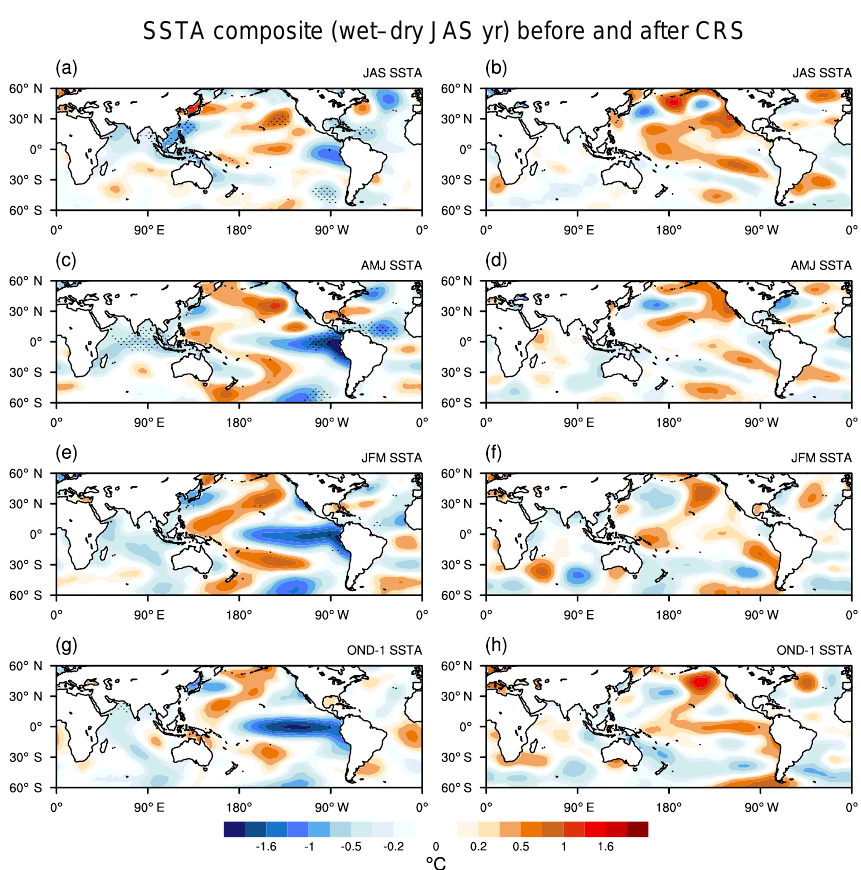
Figure 8. Evolution of SSTA composites from 0- to multi-month lead times based on wet-minus-dry years for the JAS ETWQ before (a, c, e) and after (b, d, f) the year 1999. Stippled areas indicate that the SSTA difference is at a 5% significance level according to a Student’s t